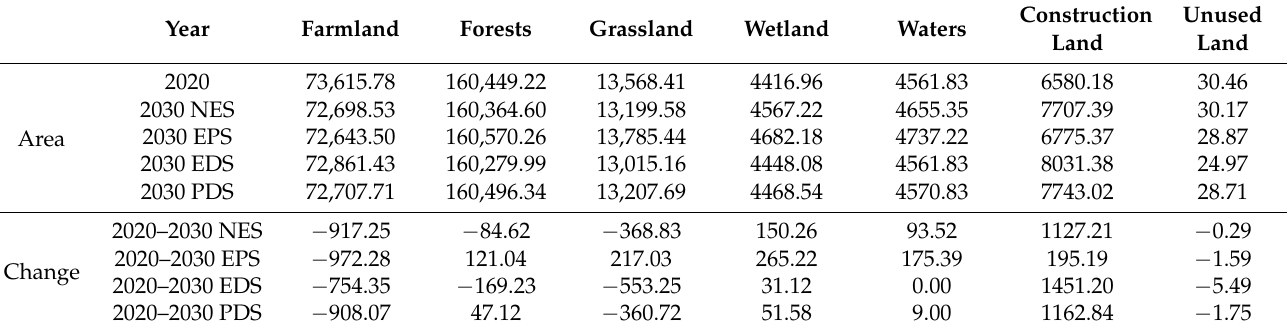
Table 3. Area and change in land-use types in DLB from 2020 to 2030 (unit: km 2